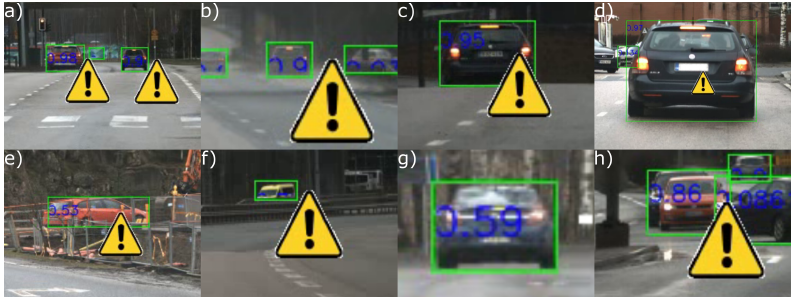
Figure 9. Example of the algorithm output. Upper row shows successful detections, and lower row unsuccessful detections. Respective confidence values in the collage from left to right: ( a ) 0.98 and 0.9, ( b ) 0.9, ( c ) 0.95, ( d ) 0.97, ( e ) 0.53, ( f ) 0.7, ( g ) 0.59, and ( h )